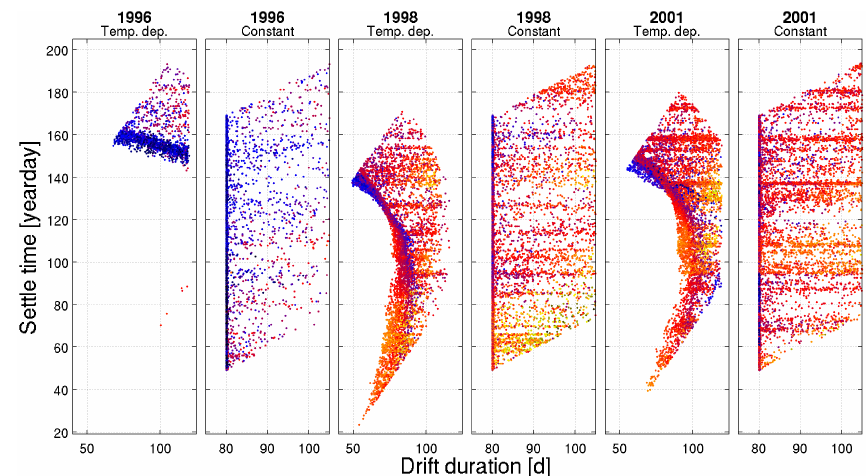
Figure 19. Comparison between the temperature-dependent development rate and a fixed development duration for 1996, 1998 and 2001. Shown is the drift duration against the settlement time for particles settling in the western Wadden